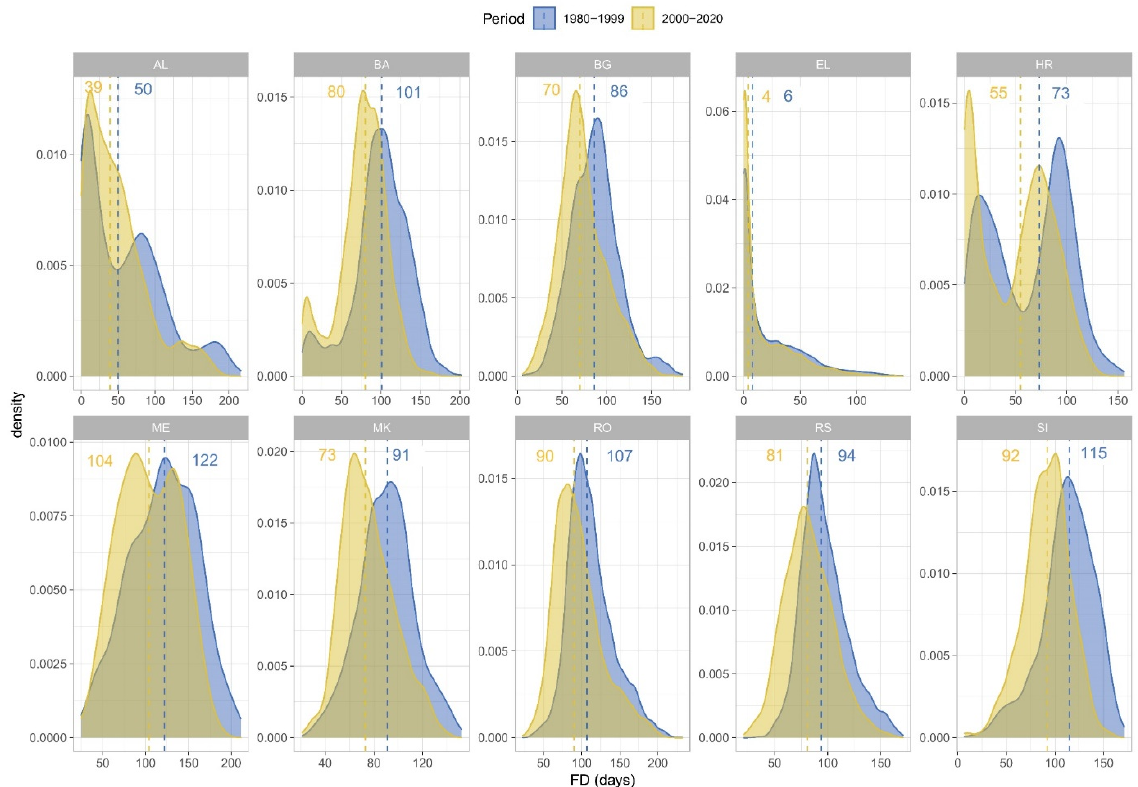
Figure 19. The frost days (FD) probability density per country for the 1980–1999 and the 2000–2020 time periods.